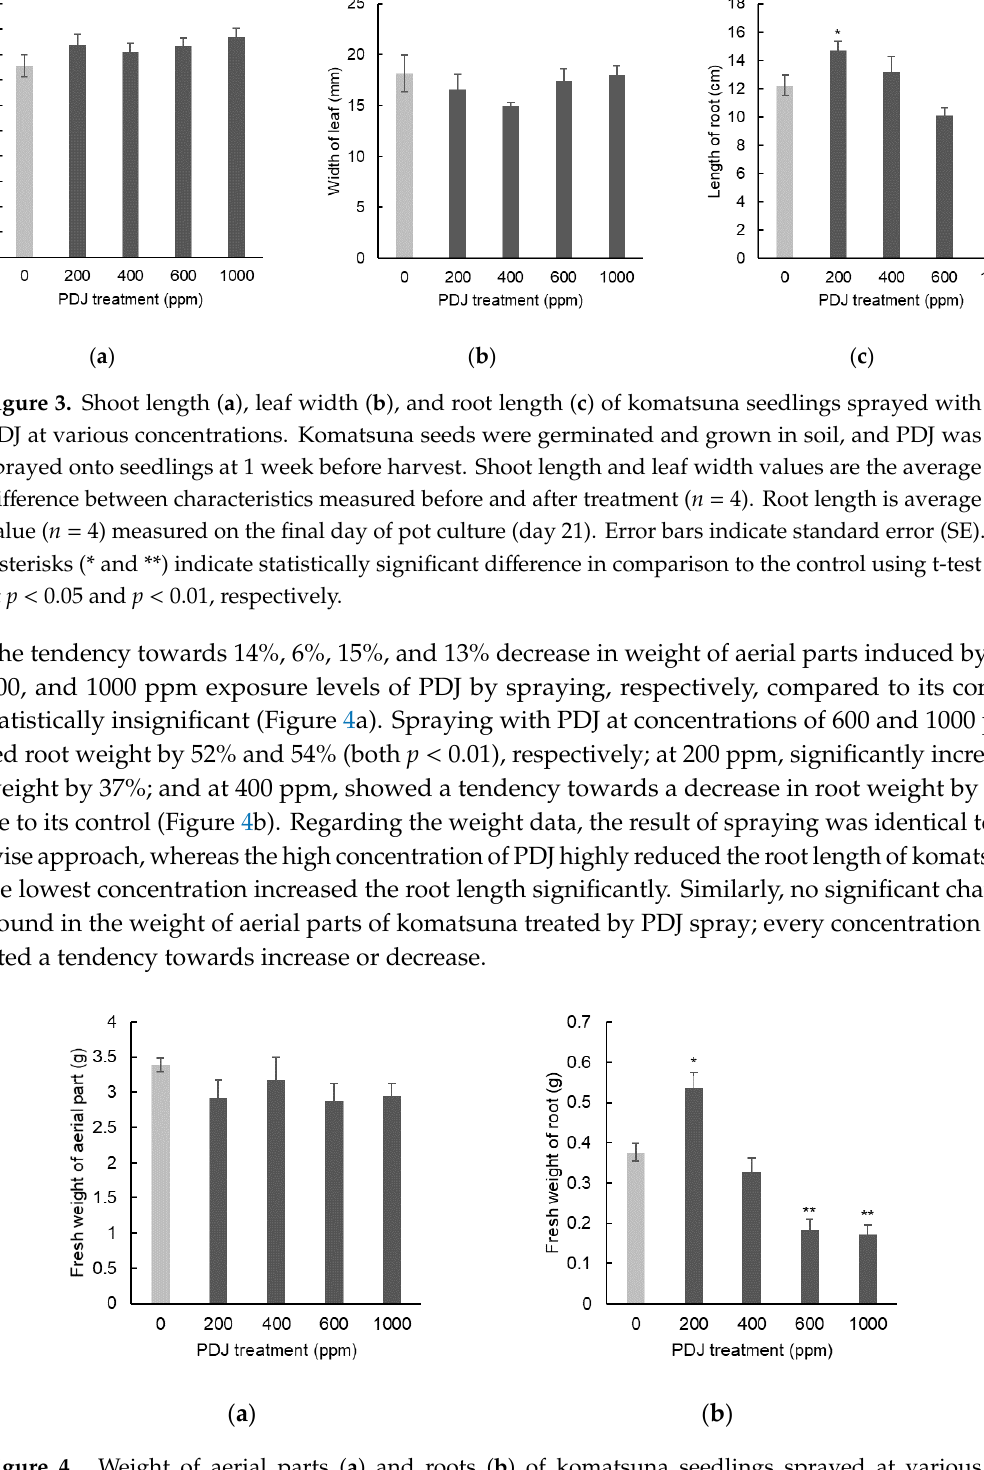
Figure 4. Weight of aerial parts ( a ) and roots ( b ) of komatsuna seedlings sprayed at various concentrations. Komatsuna seeds were germinated and grown in soil. Spray treatments of PDJ at 200, 400, 600, and 1000 ppm were applied to seedlings at 1 week before harvest. The weight of aerial parts (a) and roots (b) are shown as average values ( n = 4) measured on the final day of pot culture (day 21). Error bars indicate standard error (SE). Asterisks (* and **) indicate statistically significant difference in comparison to the control using t-test at p < 0.05 and p < 0.01, respectively. The tendency towards 14%, 6%, 15%, and 13% decrease in weight of aerial parts induced by 200, 400, 600, and 1000 ppm exposure levels of PDJ by spraying, respectively, compared to its control, was statistically insignificant (Figure 4a). Spraying with PDJ at concentrations of 600 and 1000 ppm reduced root weight by 52% and 54% (both p < 0.01), respectively; at 200 ppm, significantly increased root weight by 37%; and at 400 ppm, showed a tendency towards a decrease in root weight by 13%, relative to its control (Figure 4b). Regarding the weight data, the result of spraying was identical to the drip-wise approach, whereas the high concentration of PDJ highly reduced the root length of komatsuna, and the lowest concentration increased the root length significantly. Similarly, no